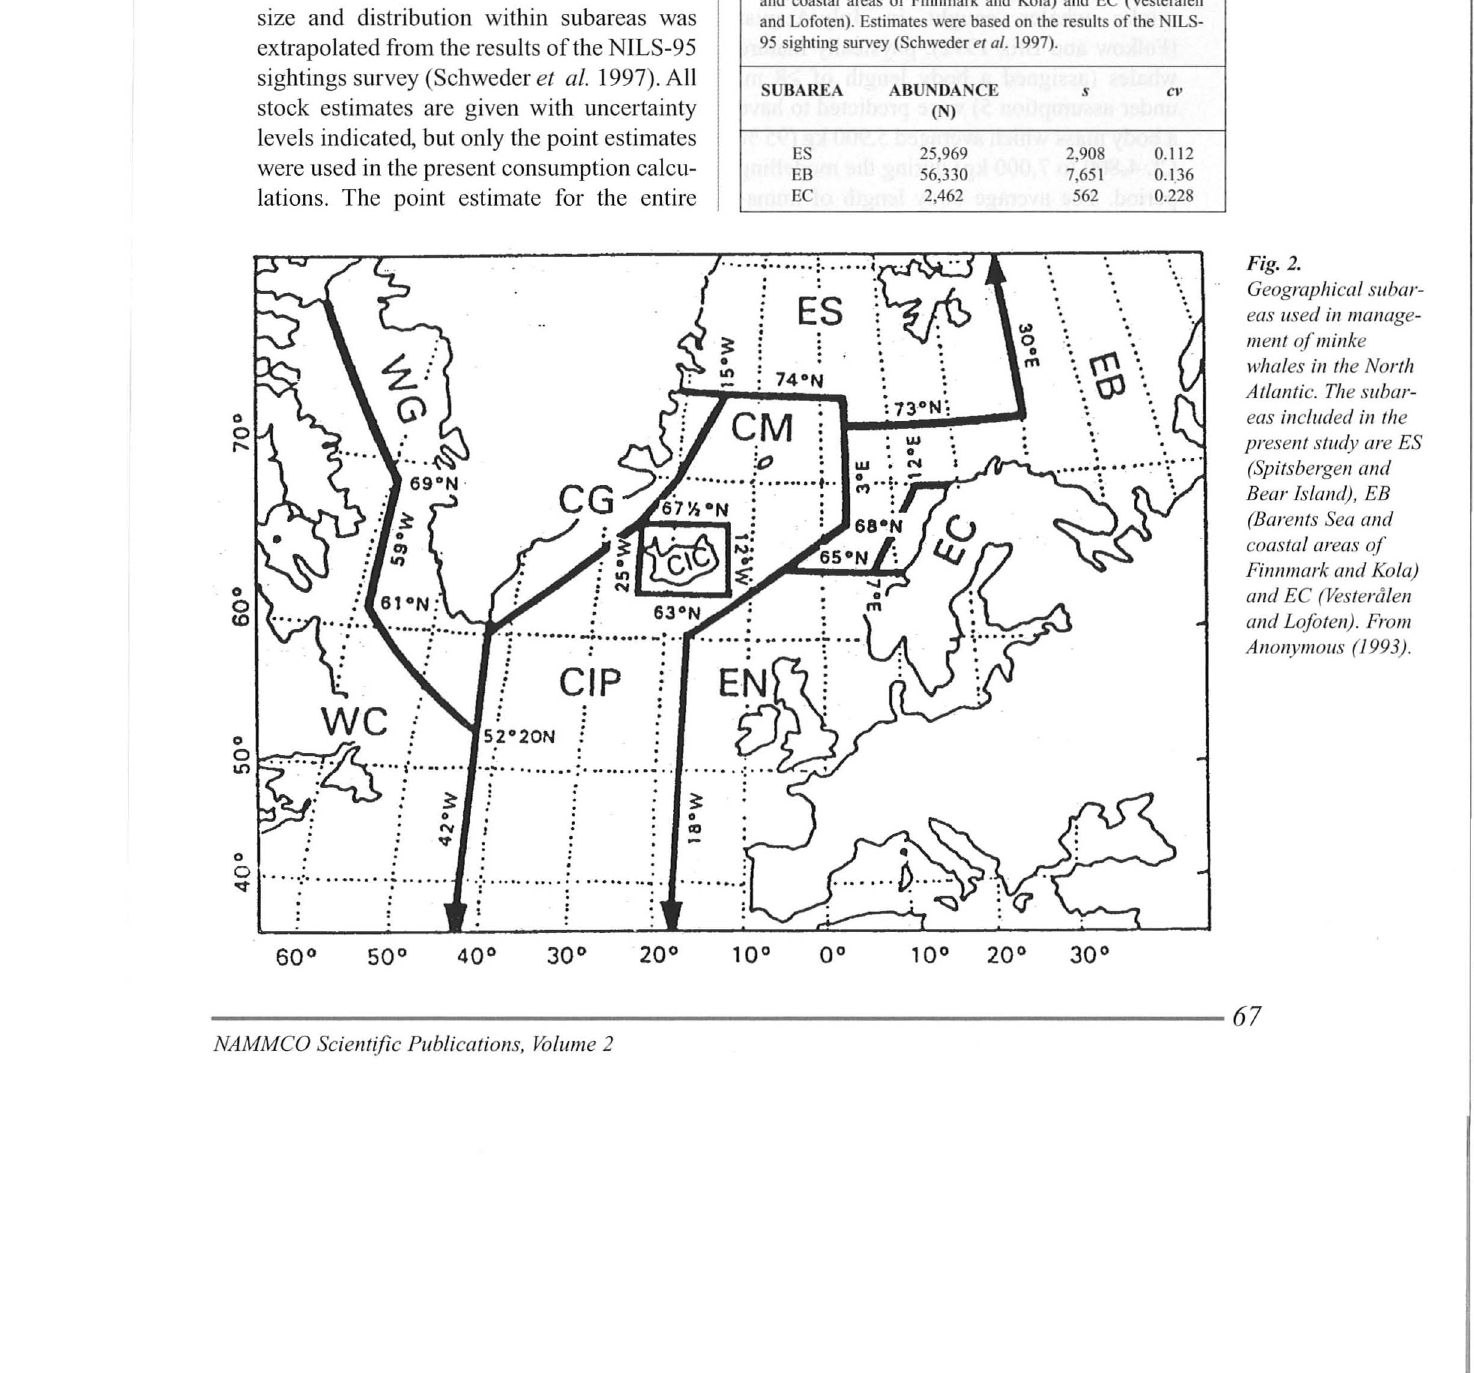
sightings survey (Schweder et al. 1997). All levels indicated, but only the point estimates were used in the present consumption calcu lations. The point estimate for the entire